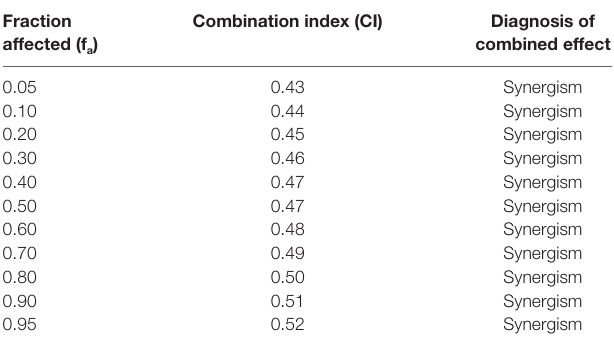
TABlE 1 | Calculated values for the combination index of flavocoxid-curcumin in combination (molar ratio, 1:7.3) for the reduction of IL-1β mRNA levels in chondrocytes.